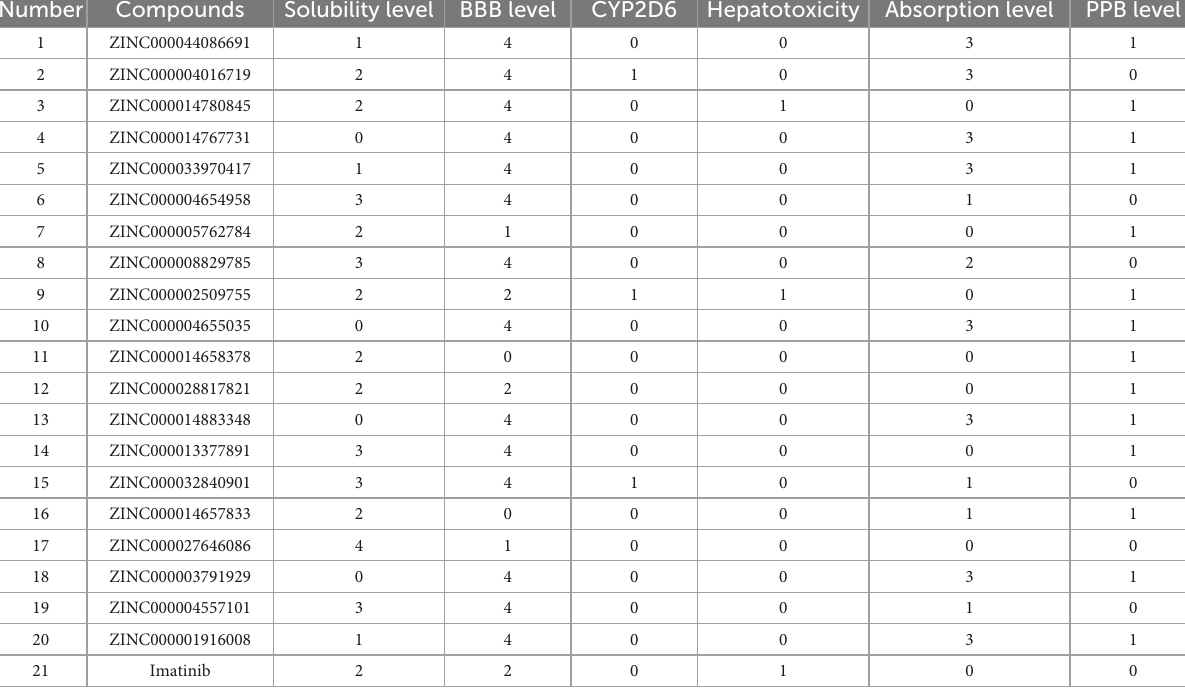
TABLE 2 Absorption, distribution, metabolism, and excretion properties of compounds.